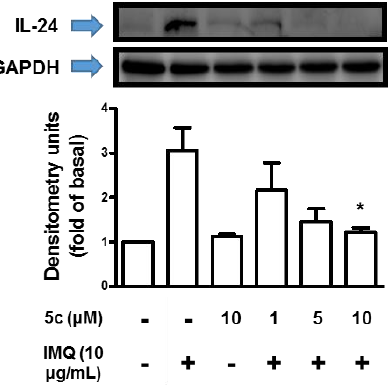
Figure 4. Effect of 5c on inhibition of IL-24 in differentiated HaCaT cells was done by Western Blot. The cells were incubated with IMQ alone, IMQ with different concentrations of 5c in media containing 2% FBS for 24 h at 37 °C. Data are presented as mean ± SD ( n = 3). Int. J. Mol. Sci. 2016 , 17 , 0000